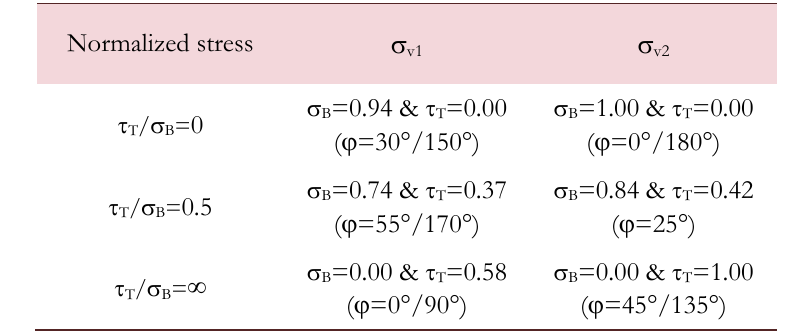
Table 1. Multiaxial fatigue assessment for 50CrMo4